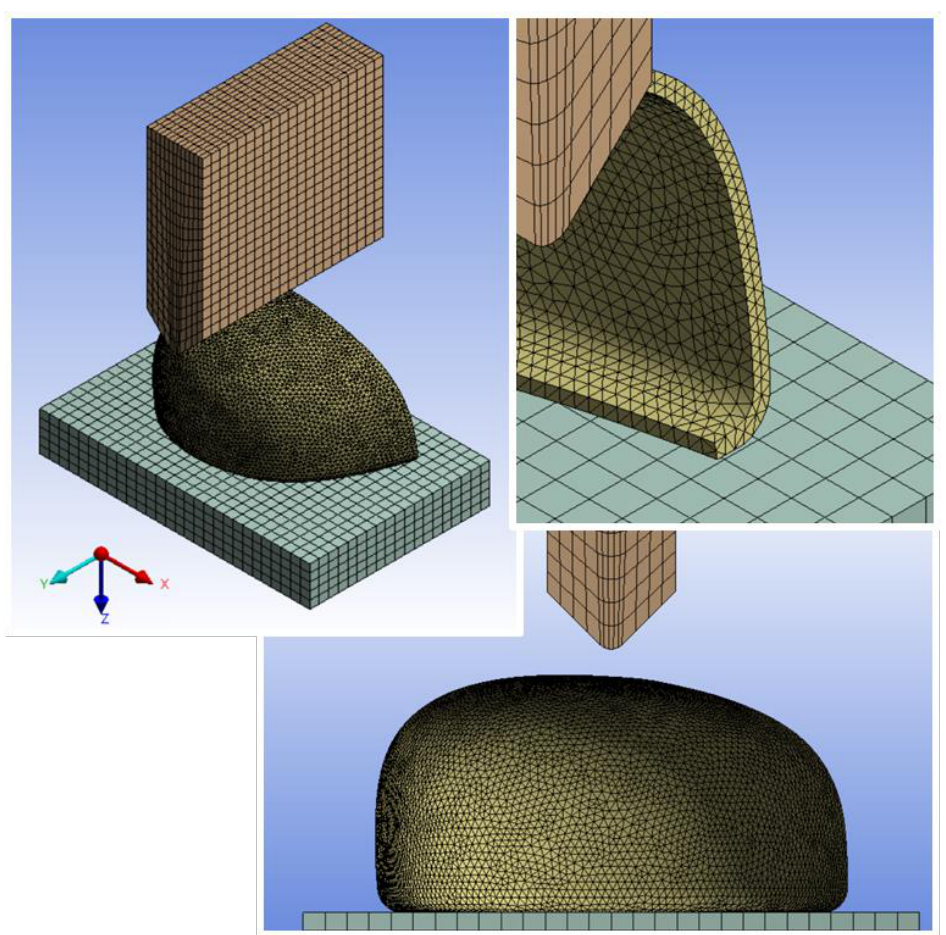
Figure 2. Finite element mesh for toecap type A (polymeric), striker, and table. The FEM boundary conditions included: the striker velocity vector immediately before impact V k = 4480 mm/s; loading Q = 18.8 kg applied to the upper surface of the striker (to give an overall loading of 20 kg including the weight of the striker of 1.2 kg); and attachment with three blocked degrees of freedom (x, y, z) on the upper surface of the baseplate as shown in Figure